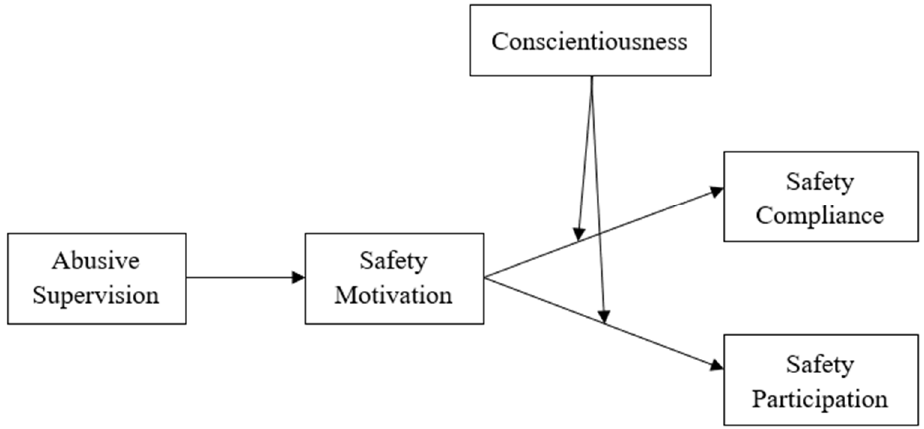
Figure 1. Moderated mediation model.